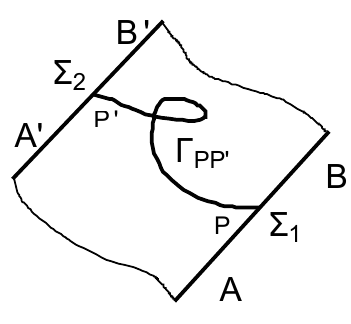
Figure 5 . The codimension surface (cid:0) where the conformal dimension and charge of these twist (cid:12)elds (cid:8)